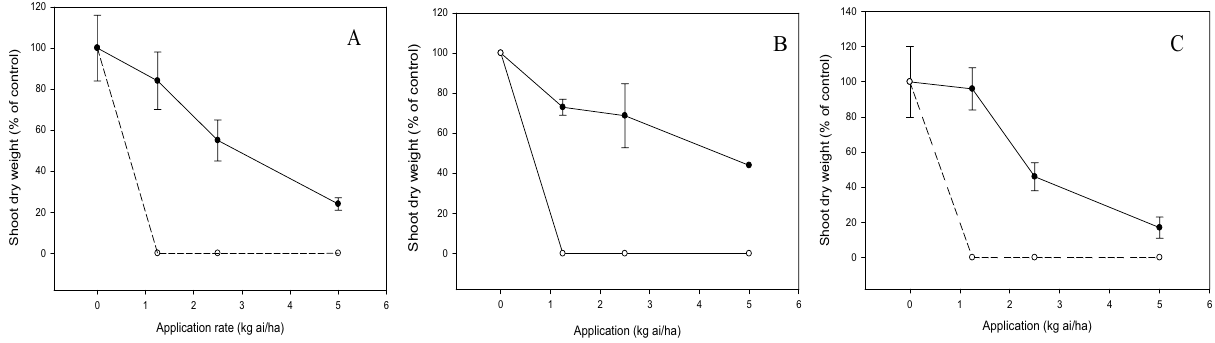
Figure 6. Herbicidal effects of c (solid line) and diuron (dashed line) treatments on shoot dry weight of Eleusine indica ( A ), Oldenlandia verticillata ( B ), and Cyperus iria ( C ) respectively 2 weeks after pre-emergence application.